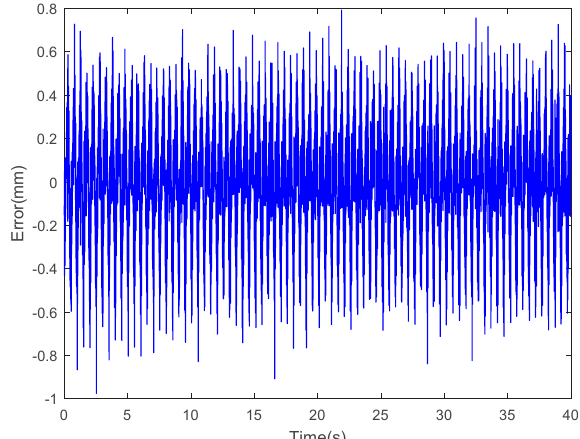
Figure 23. Error of the LSSVM ‐ NARX model at sinusoidal actuating voltage with amplitude of 2V and frequency of 1 / 2 π Hz (RMSE = 0.5147).